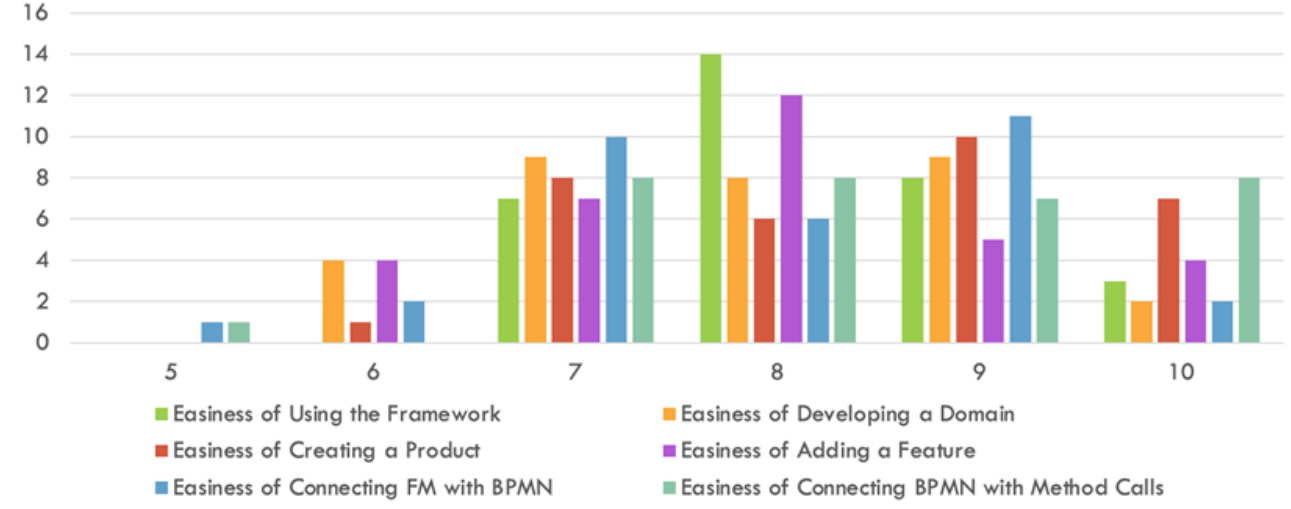
Figure 13. Easiness of the